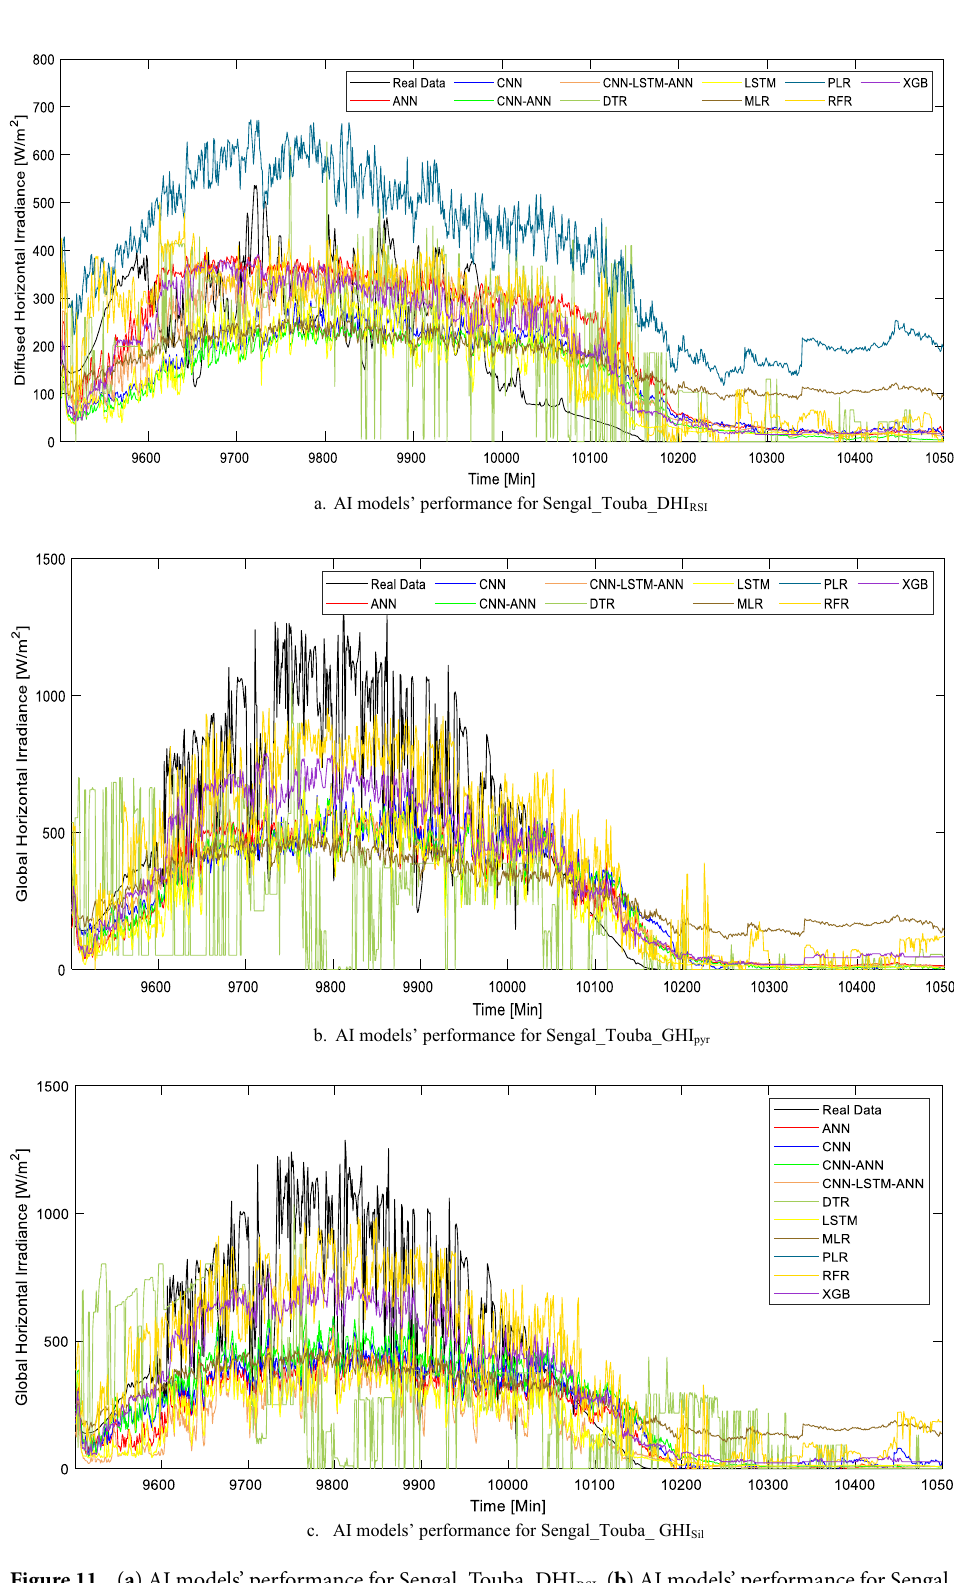
Figure 11. ( a ) AI models’ performance for Sengal_Touba_DHI RSI . ( b ) AI models’ performance for Sengal_ Touba_GHI pyr . ( c ) AI models’ performance for Sengal_Touba_ GHI Sil